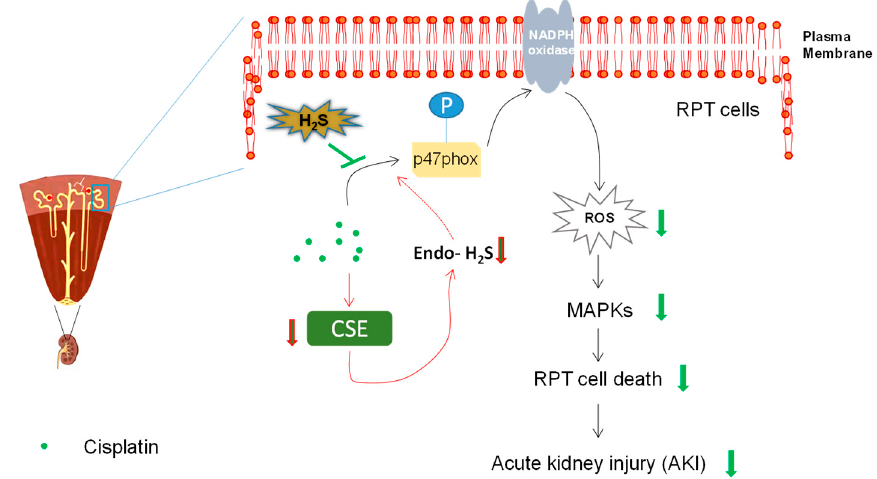
Figure 4. Protective effect of H 2 S in cisplatin-induced nephrotoxicity. Cisplatin led to the reduction of endogenous H 2 S by downregulating the expression of H 2 S-producing enzyme cystathionine γ -lyase (CSE), which may be involved in the subsequent renal proximal tubule (RPT) cell death and nephrotoxicity. Furthermore, H 2 S donors such as NaSH and GYY4137 ameliorated cisplatin-induced renal toxicity in vitro and in vivo, probably by suppression of NADPH oxidase activation, downstream reactive oxygen species (ROS) generation, and mitogen-activated protein kinases (MAPKs)